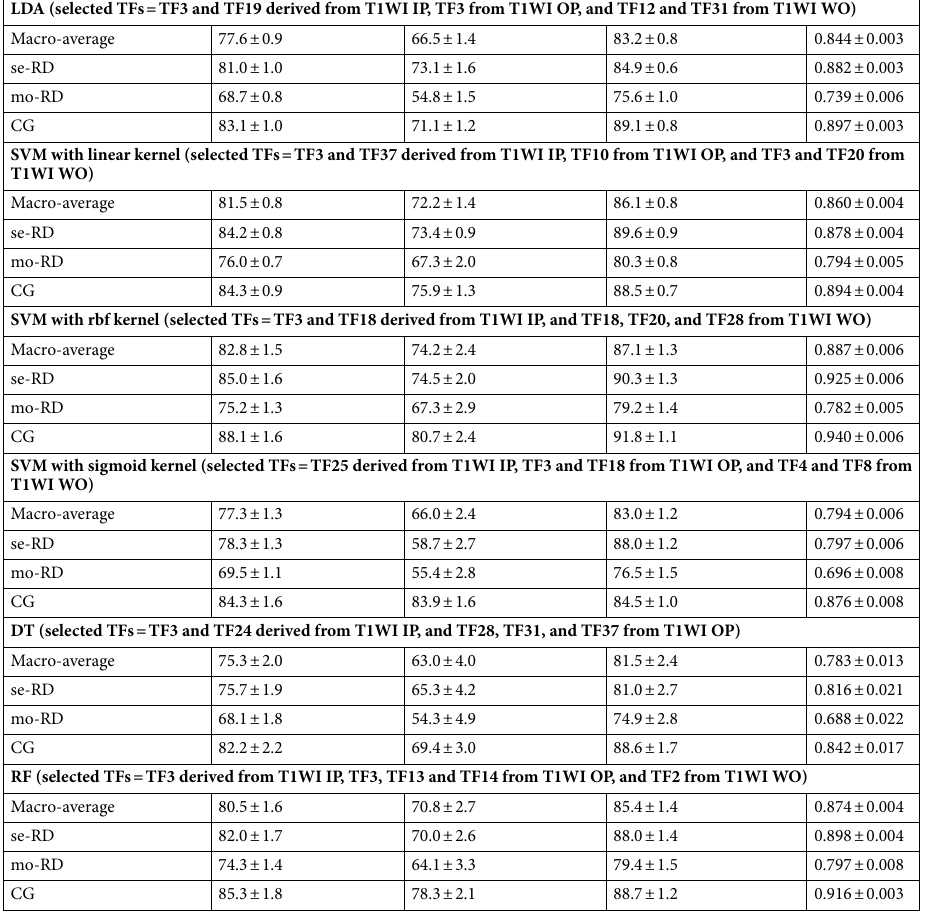
Table 9. Performance of each classification attempt in discriminating between the three groups in all T1-weighted imaging methods (ALL T1WIs). AUC area under the curve, IP in-phase, OP opposed-phase, T1WI T1-weighted imaging, TF texture feature, WO water-only, DT decision tree, LDA linear discriminant analysis, SVM support vector machine, RF random forest classifier, se-RD severe renal dysfunction (estimated glomerular filtration rate [eGFR] < 30 mL/min/1.73 m 2 , i.e., CKD stage G4–5), mo-RD moderate renal dysfunction (30 ≤ eGFR < 60 mL/min/1.73 m 2 , i.e., CKD stage G3a/3b), CG control group (eGFR ≥ 60 mL/ min/1.73 m 2 , i.e., CKD stage G1–2). Feature name codes are as follows: TF2 = 90th percentile, TF3 = energy, TF4 = entropy, TF8 = median, TF10 = root mean squared, TF12 = uniformity, TF13 = difference average, TF14 = difference entropy, TF18 = joint energy, TF19 = joint entropy, TF20 = maximum probability, TF24 = dependence variance, TF25 = gray level non uniformity (gray-level dependence matrix), TF28 = gray level non uniformity (gray-level run length matrix), TF31 = run entropy, TF37 = gray level non uniformity normalized. The data are expressed as means ± standard